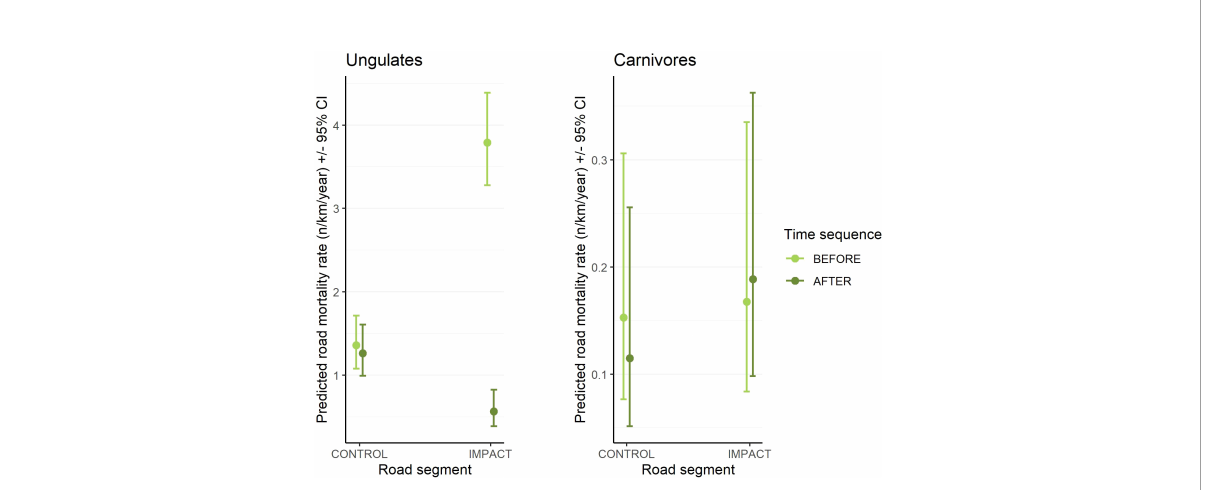
FIGURE 3 Predicted effects of the mixed-effects, Poisson regression showing the interaction between road segment (control vs impact) and time sequence (before vs after) on the collision rate of all ungulates ppoled together (left panel) and all carnivore species pooled together (right panel). For ease of illustration, only the main effects of the model are shown here. The complete statistical model included an AR1 autogressive term for year nested within study area to account for temporal autocorrelation and a random intercept for study area. Note different scales on the